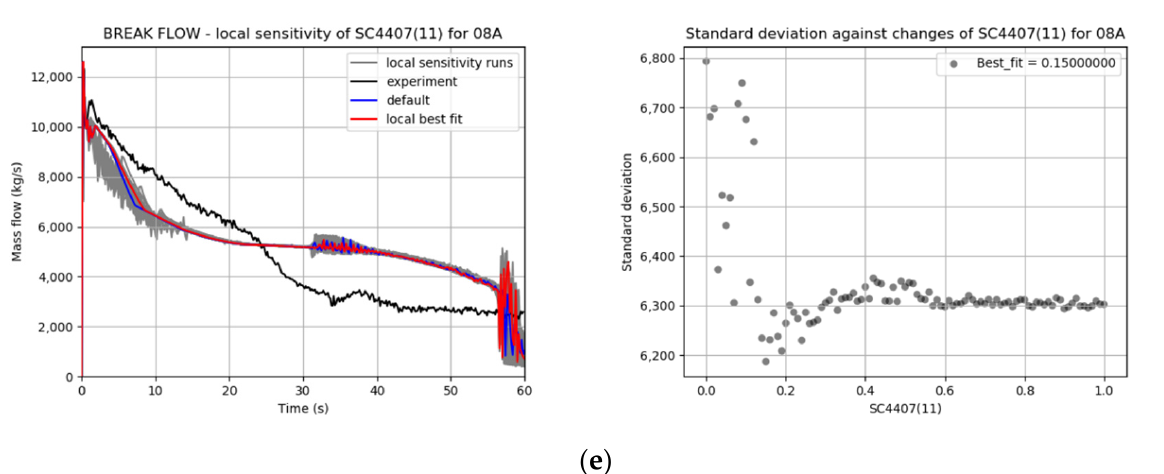
Figure 8. Local sensitivity analysis for the chosen parameters for the 08A nodalization. ( a – e ) Different parameters: left— break flow and right—standard deviation for best-fit approach. CDCHKF_FL—Discharge Factor, SC4402(1)—Choking velocity limit, SC4402(2)—Moody model multiplication factor, SC4407(1)—Bubble rise velocity, and SC4407(11)—Maximum void fraction.